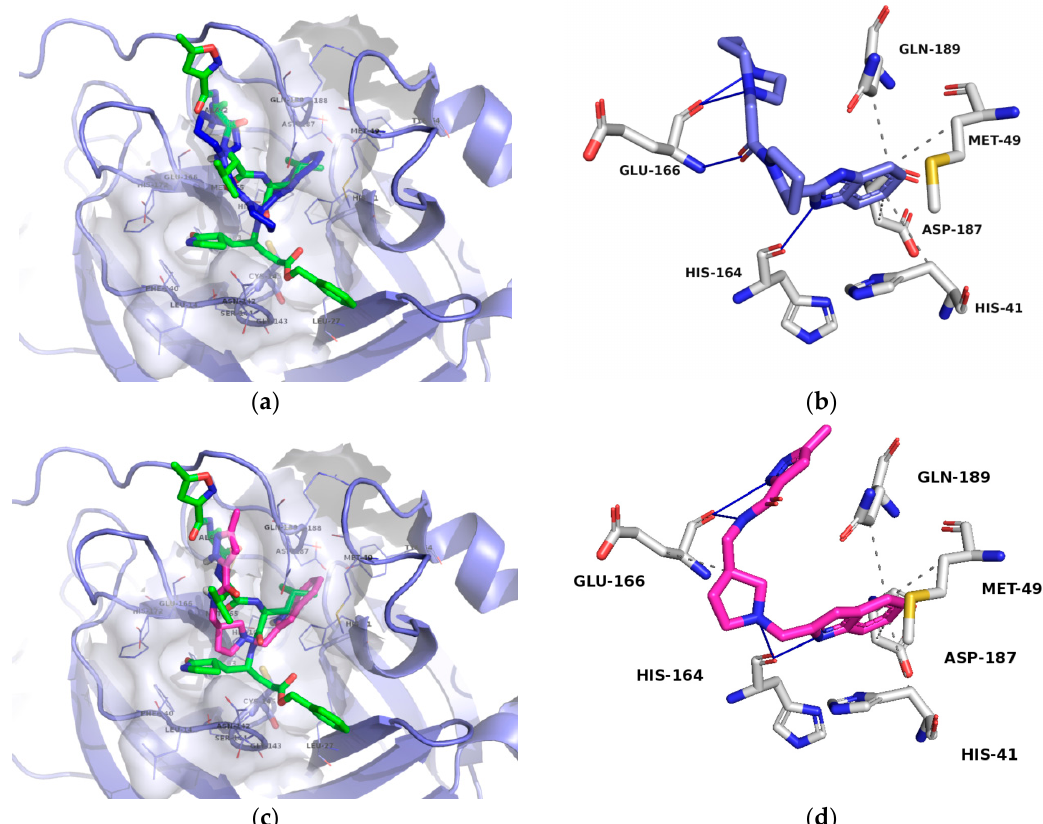
Figure 5. ( a ): Compound 1 binding mode presented in blue colored stick model; ( b ): Compound 1 key interactions; ( c ): Compound 2 binding mode presented in cyan colored stick model. Reference N3 ligand from the PDB ID: 6LU7 is depicted in green-colored stick model and the protein surface around the ligand calculated. ( d ): Compound 2 key interactions. Hydrogen bonds are denoted as blue lines and hydrophobic interactions as grey lines.